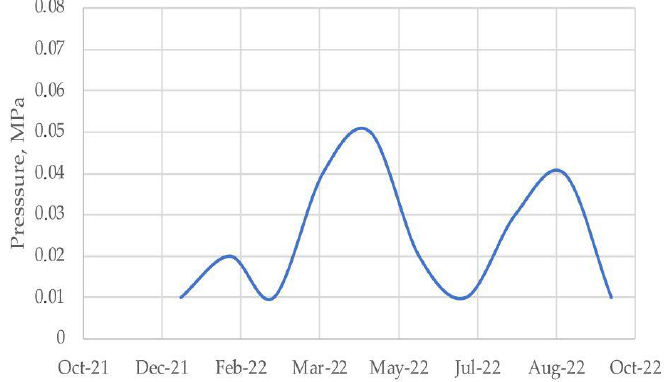
Figure 7. Change in intercasing space pressure after colmatating.